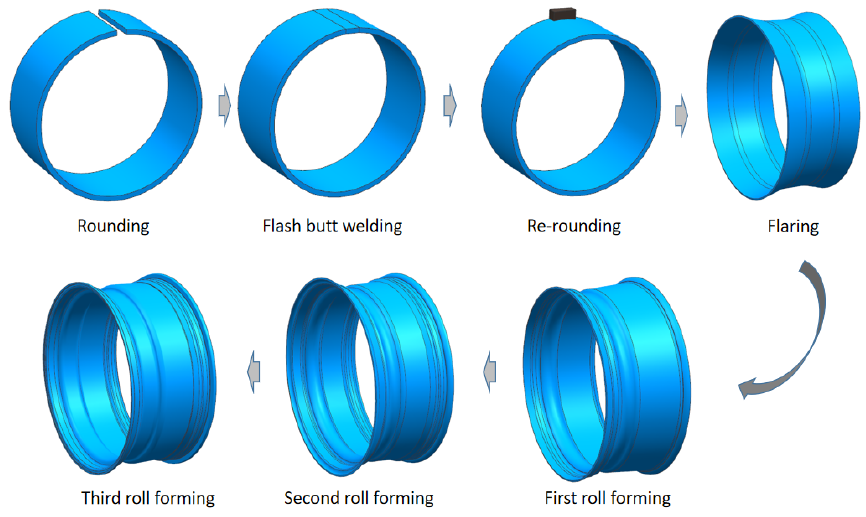
Figure 1. Conventional forming process of steel wheel rim.